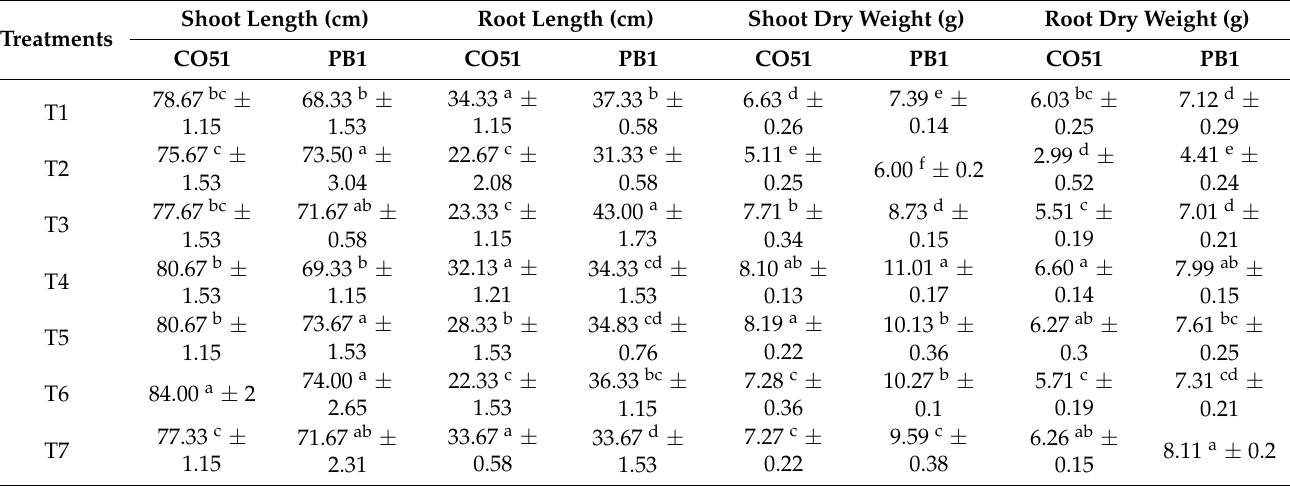
Table 1. Effect of inoculation of halotolerant endophytes and rhizobacteria on growth parameters of two rice varieties, CO51 and